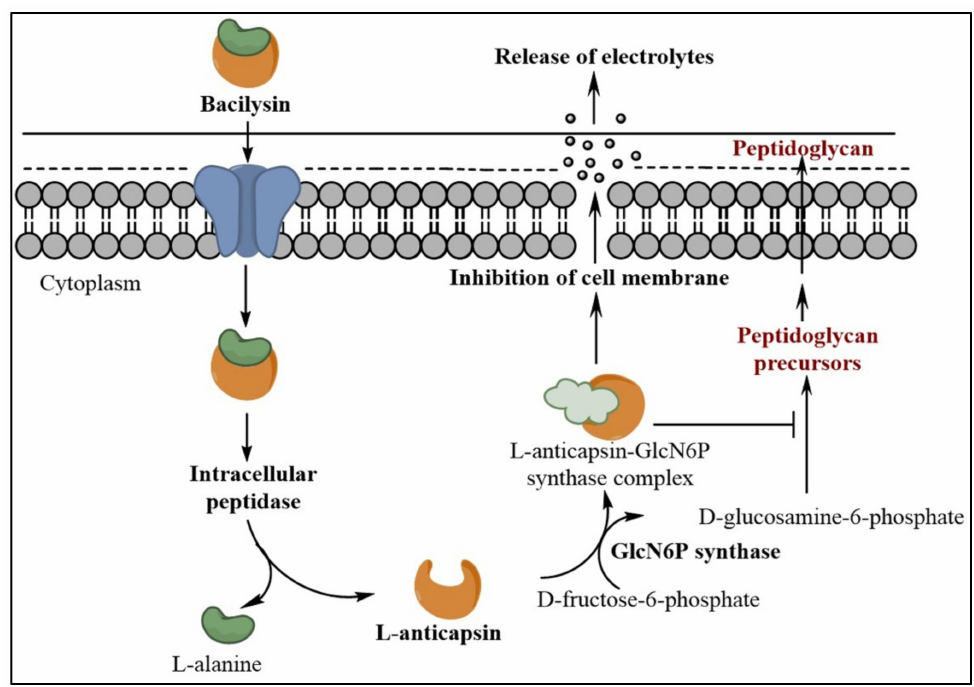
Figure 1. Mechanism of action of bacilysin during the inhibition of microbial cell wall